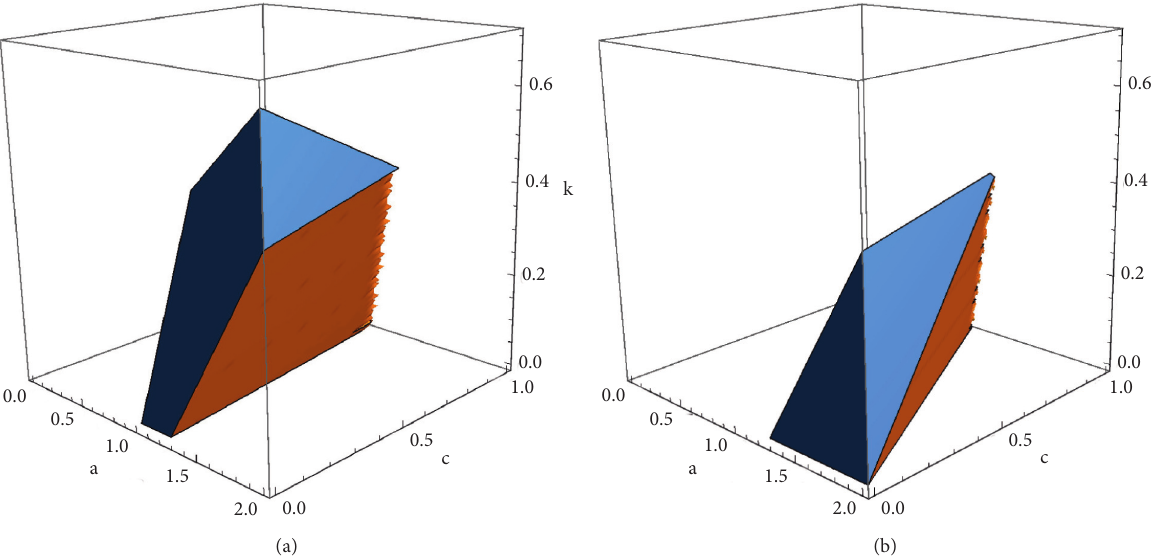
Figure 10: The existence of both scenarios: (a) the case c < 5 + 7 k − 4 a w.r.t. a , c , and k and (b) the case c > 5 + 7 k − 4 a w.r.t. a , c , and k